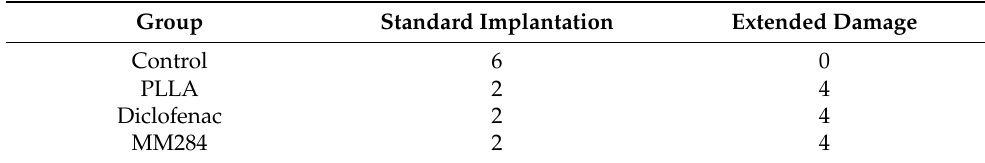
Extended damage = implantation of the electrode in scala vestibuli or even in the middle turns.